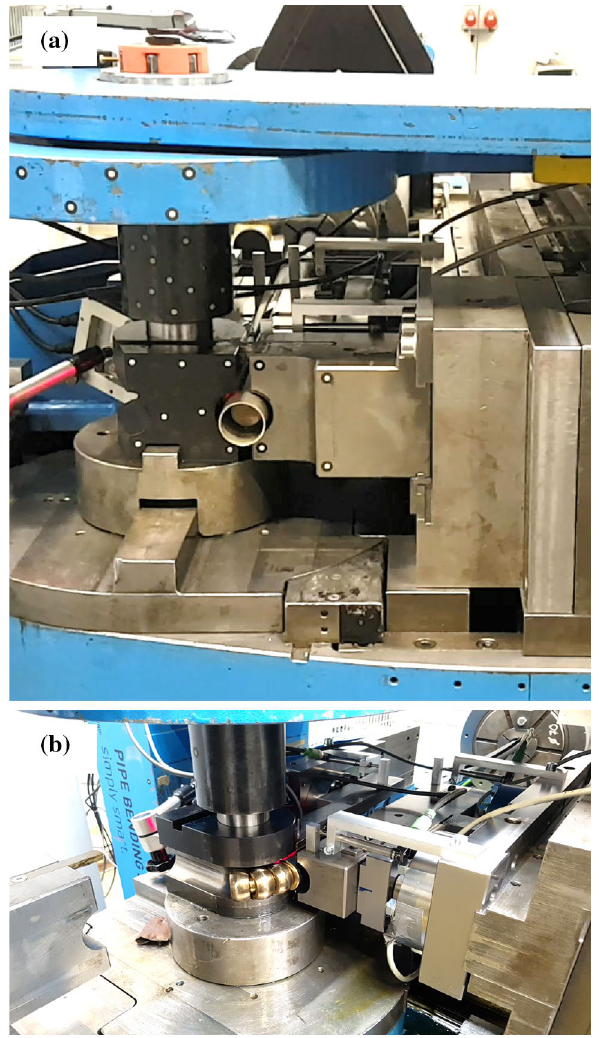
Fig. 20 a and b Experimental setup of practical RDB tests